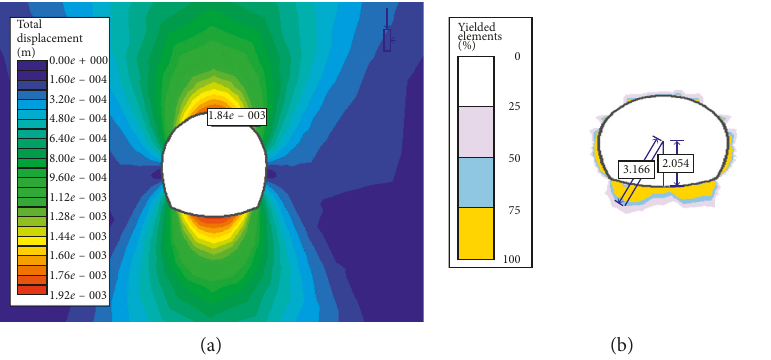
Figure 2: Maximum displacement and thickness of plastic zone before